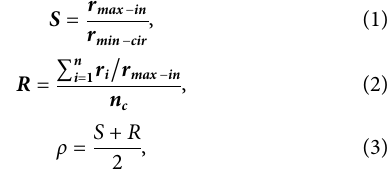
Frontiers in Earth